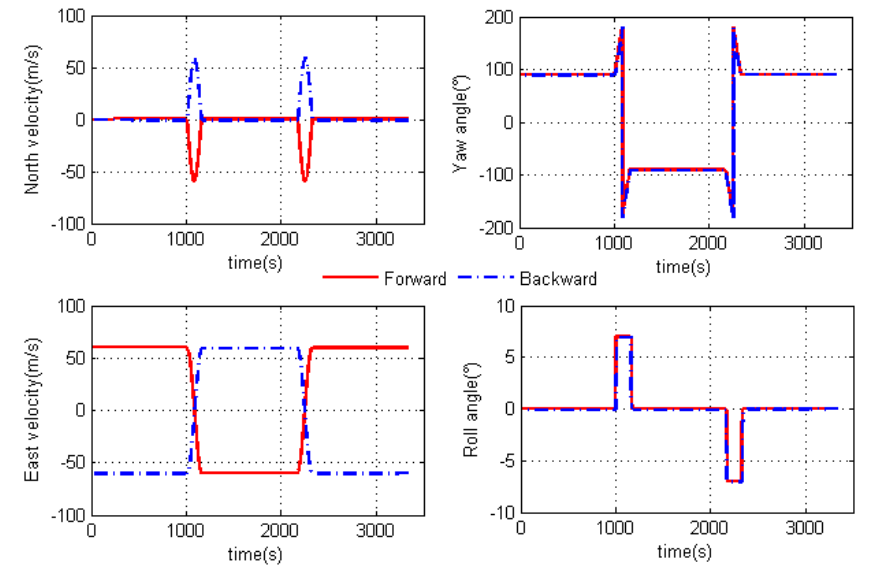
Figure 4. Pure inertial navigation results in two algorithms.